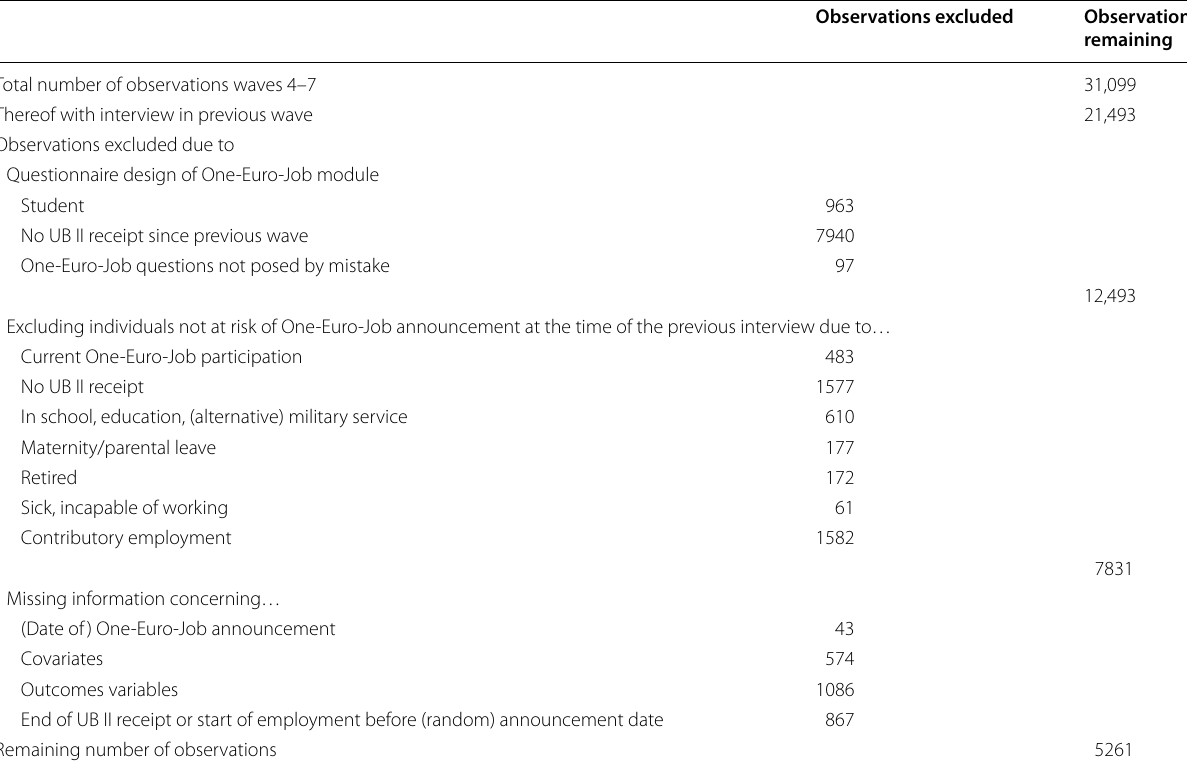
Table 2 Sample selection. Source: PASS_0613_v1, Statistics Department of the German Federal Employment Agency